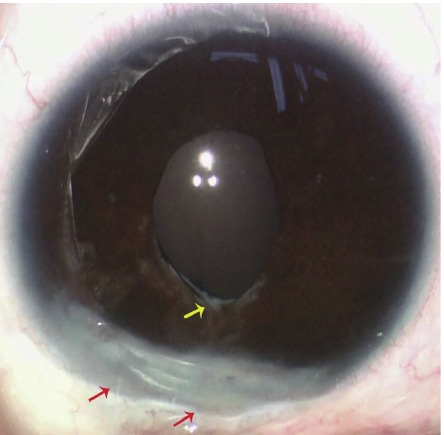
Figure 2: The anterior segment of the patient who exhibited intraoperative bleeding. This case presented with superior corneal leukoma (red arrows), superior posterior synechiae with fibrous membrane (yellow arrow), and peripheral anterior